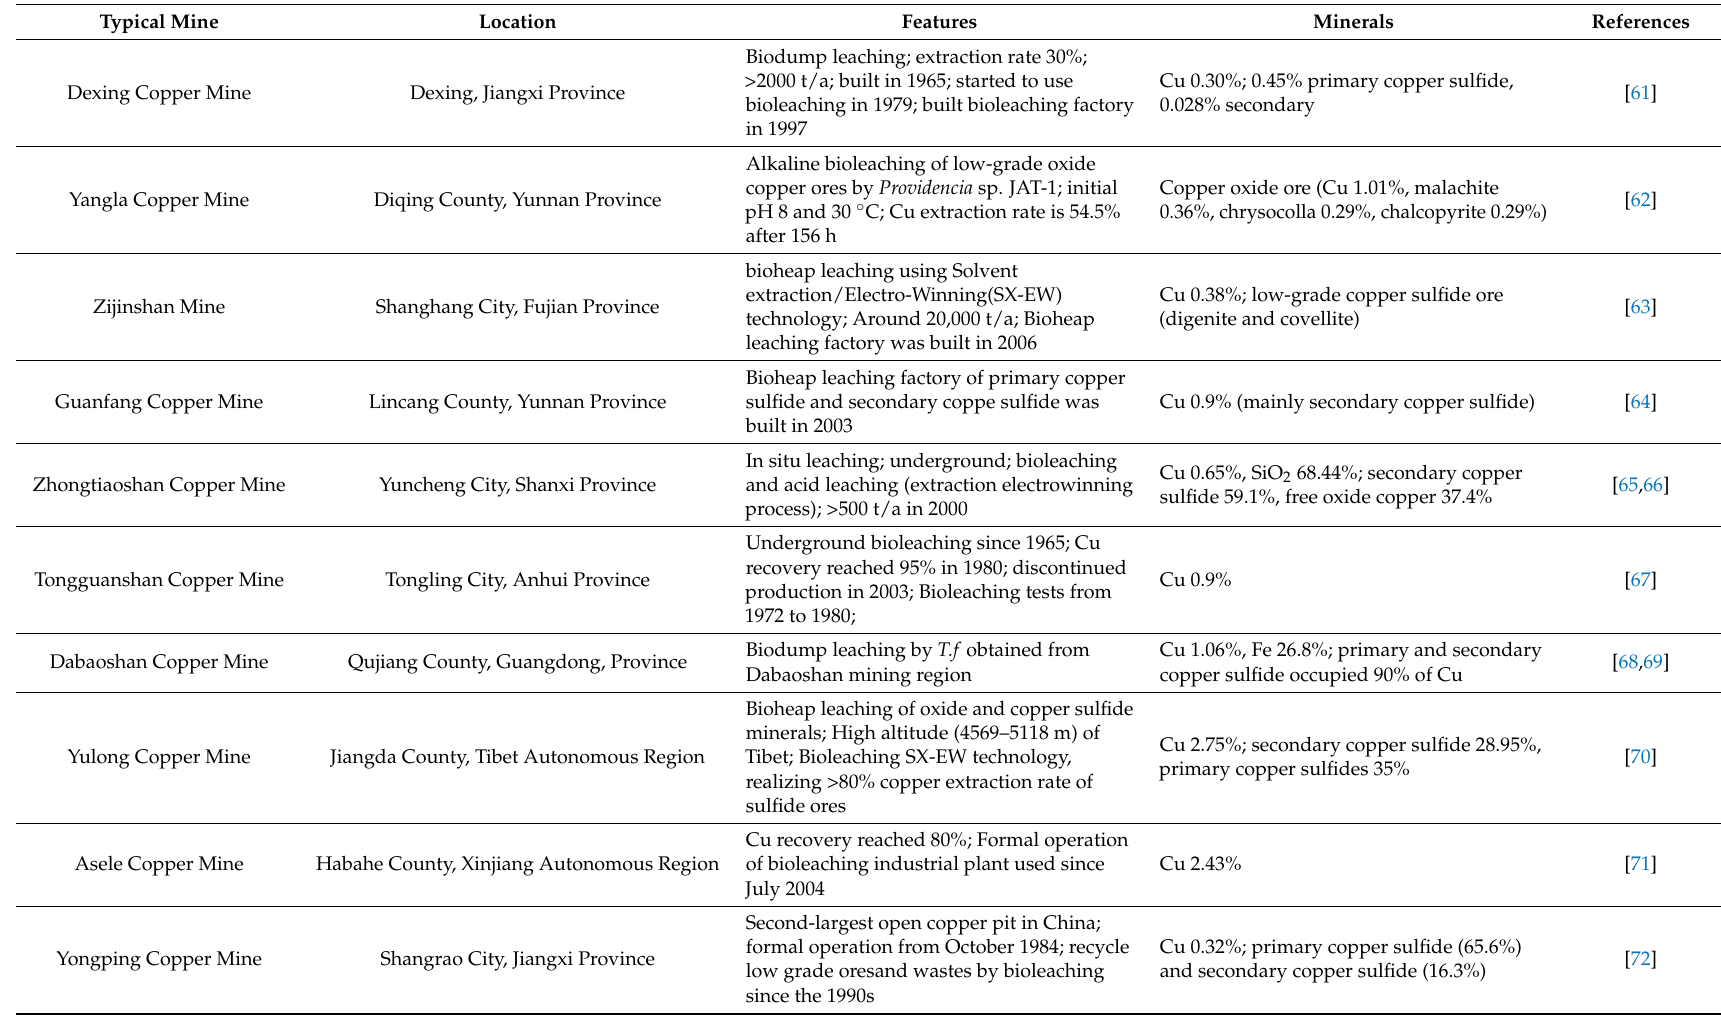
Table 1. Exploration and successful industrial cases of copper bioleaching in